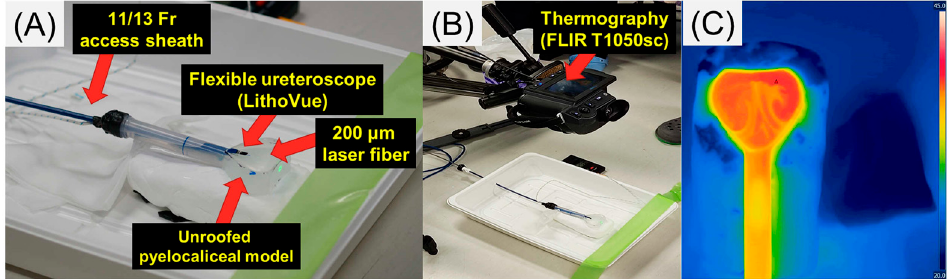
Figure 1. ( A ) Experimental setup; ( B ) thermography setup; ( C ) moving image of the irrigation tem- peratures.